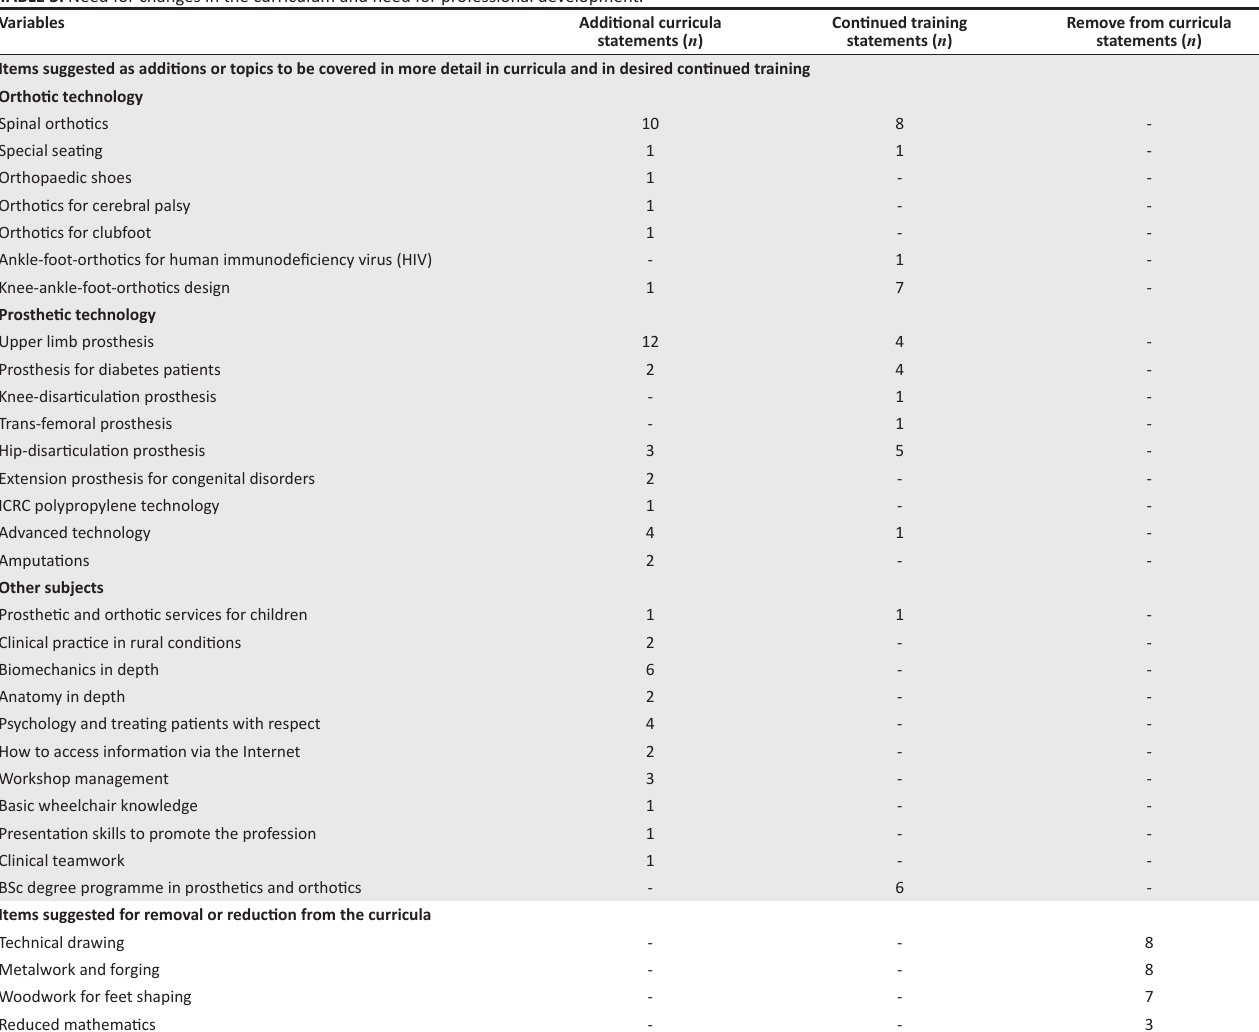
TABLE 3: Need for changes in the curriculum and need for professional development.